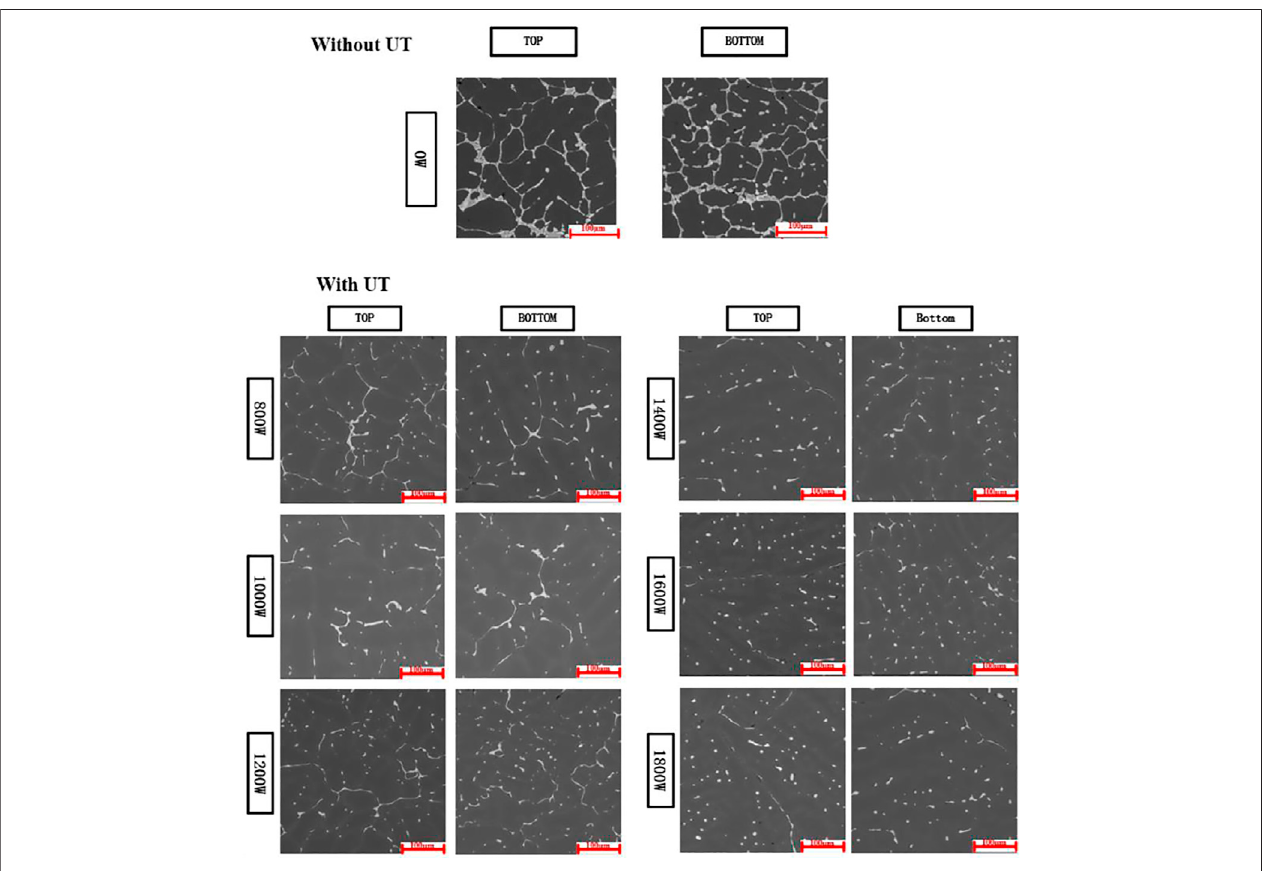
FIGURE 7 | SEM images of precipitated phases in representative positions of 2195 ingots under different ultrasonic power treatments.